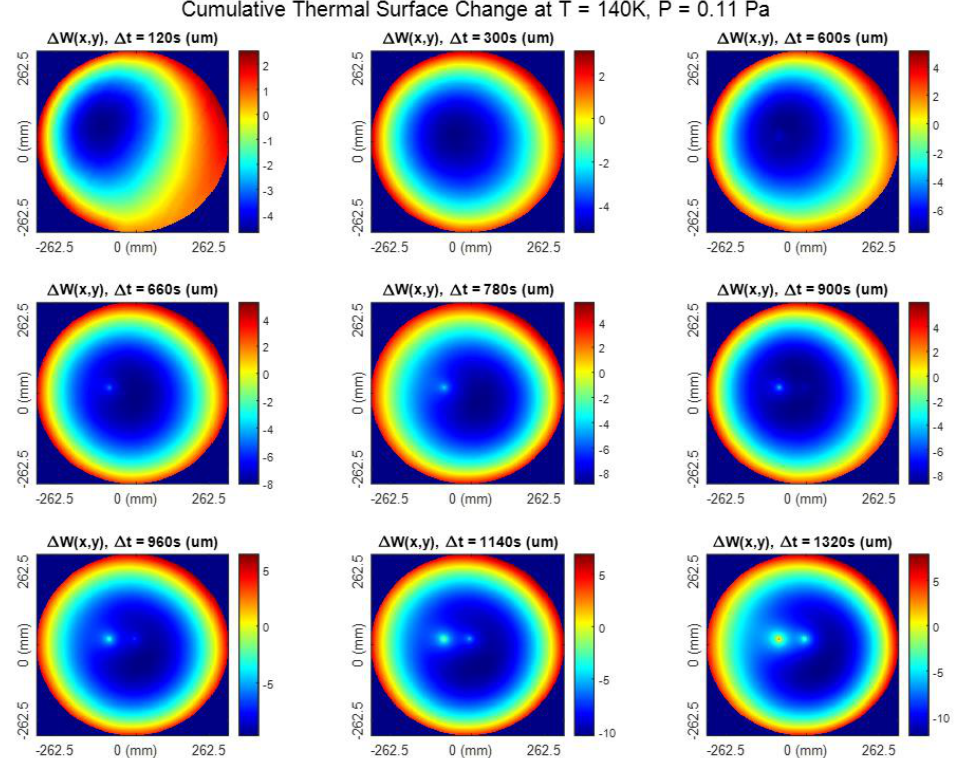
Figure 9. Shape differences were observed successively on the timescale of hundreds of seconds. It is interesting that the proximity of the heat source to the northern region of the UUT did not produce local non-uniformity at the center aperture region despite local temperature differences. In this experiment, the inflatant gas was Argon, which most recently expelled a mix of Helium, Argon, and Xenon from the lenticular UUT volume.